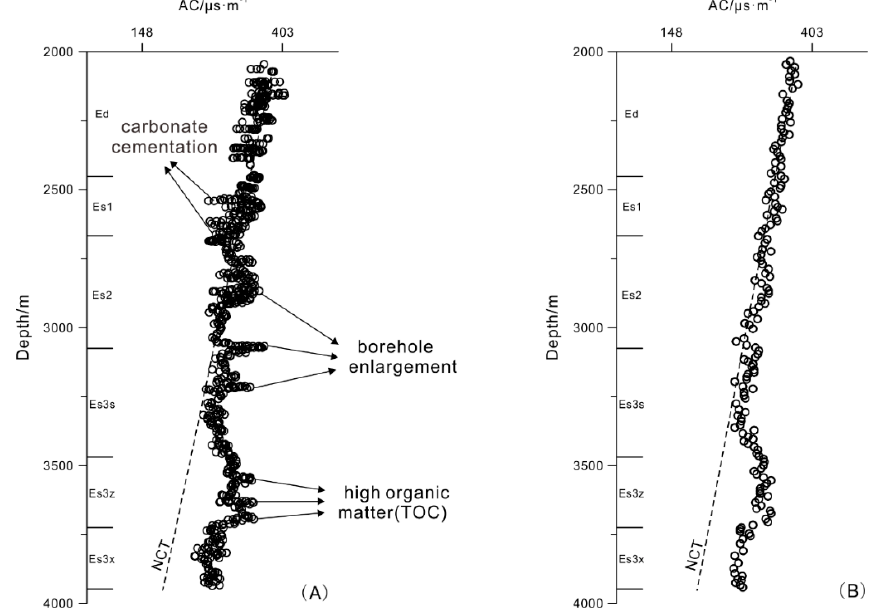
Figure 11. Mudstone compaction curves for well X942 in the Linnan Sag. ( A ) The compaction curve before elimination has a scattered data distribution. The lower acoustic values are due to the carbonate cementation in Es1, the abnormally high acoustic values in Es2 and Es3s are due to borehole enlargement, and the abnormally high acoustic difference between Es3z and Es3x is due to the high organic matter content. ( B ) The compaction curve after elimination of multiple factors is more regular. The well location is shown in Figure 1C.